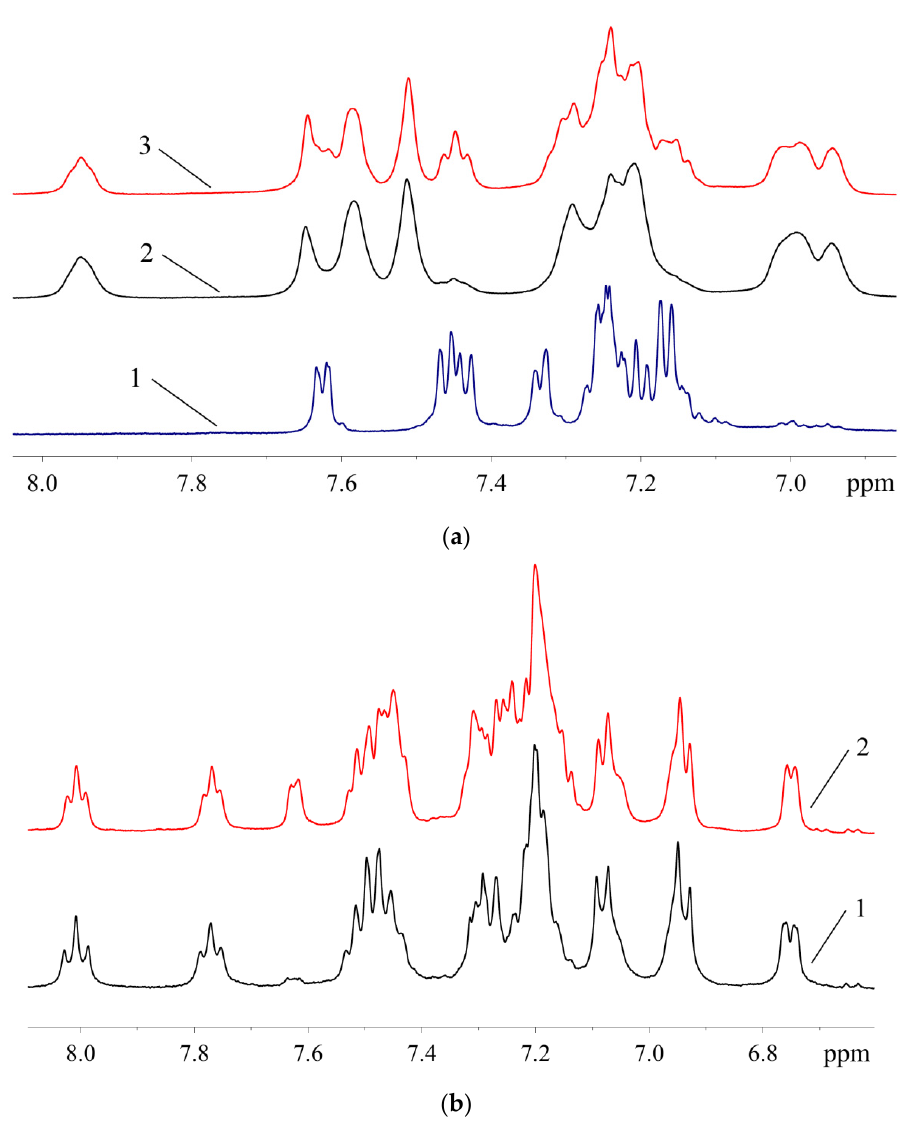
Figure 14. Aromatic region of the 1 H-NMR spectra: ( a )— 1 (1), samples of XPhos Pd G3 containing 8.5% (2) and 26.4% (3) of 1 ; ( b )—samples of RuPhos Pd G3 containing 9.3% (1) and 29.0% (2) of 1 .